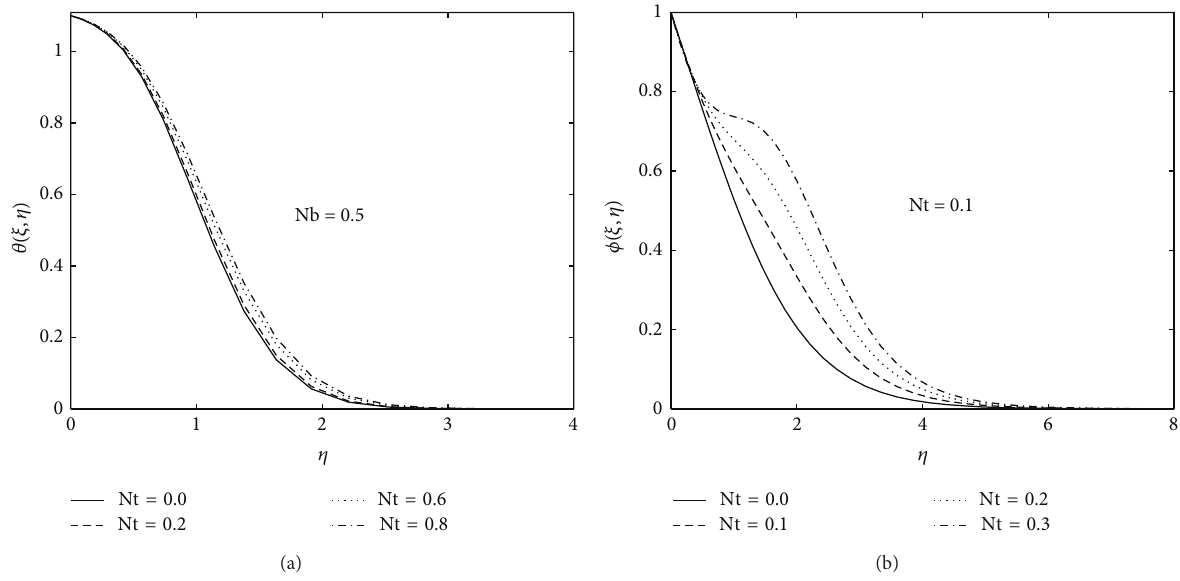
Figure 5: Effect of the Nt on 𝜃(𝜂) and 𝜙(𝜂) for 𝜉 = 0.5 , Le = 10 , Pr = 7 , 𝜎 = 0.3 , Nr = 0.1 , Nb = 0.5 , and 𝐴 = 0.1 .